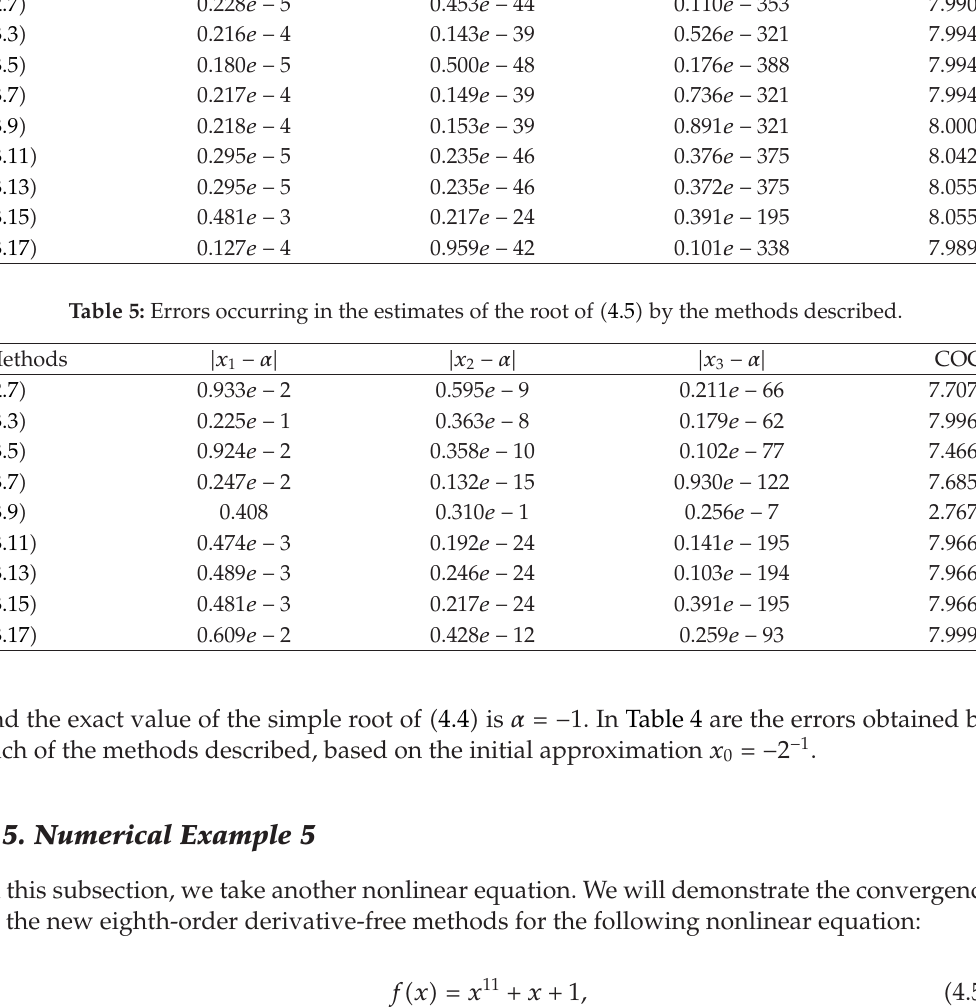
Table 4: Errors occurring in the estimates of the root of (cid:3) 4.4 (cid:4) by the methods described. Methods